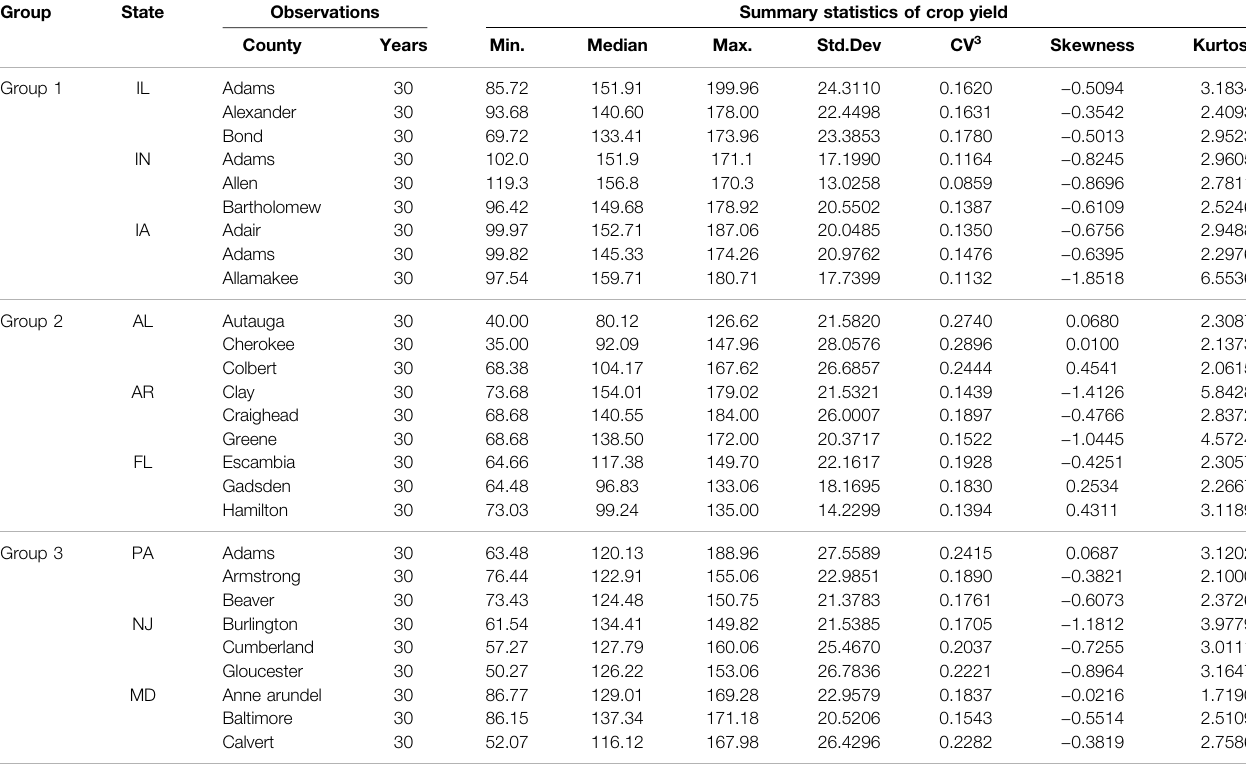
TABLE 2 | Summary statistics of average county-level yield (bushel per acre) of corn, by counties. Group State Observations Summary statistics of crop